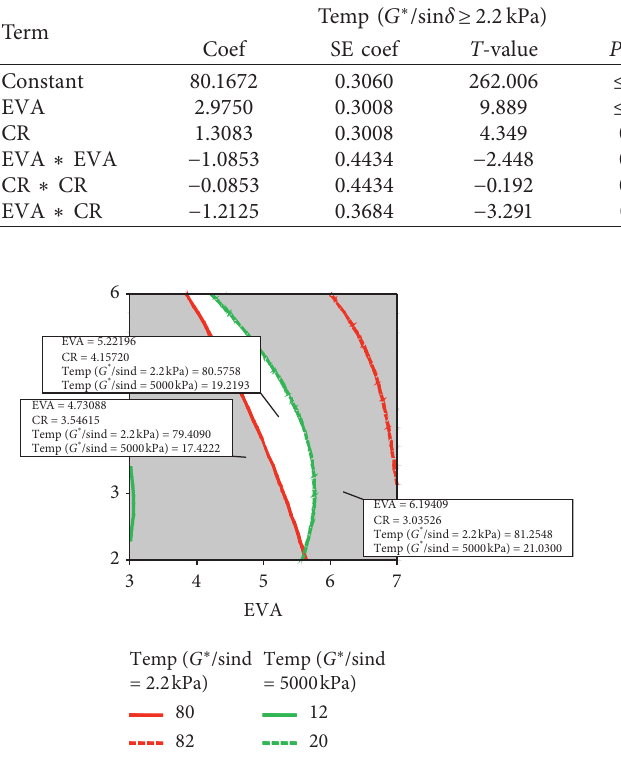
Figure 5: Contour plot of temperature ( G ∗ /sin δ ≥ 2.2kPa and G ∗ /sin δ ≤ 5000kPa).